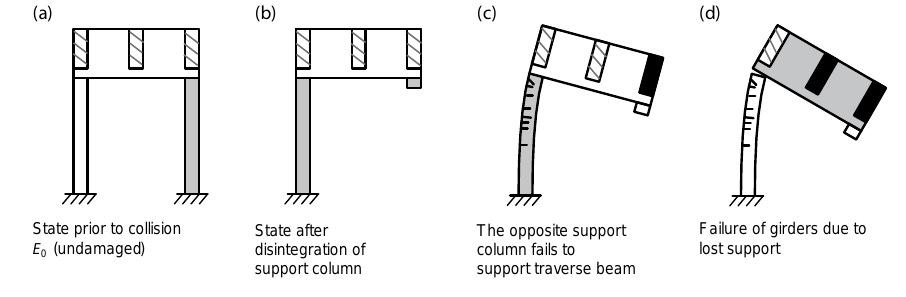
fig. 9. Simple visualisation of the event sequence of the road 26.5 bridge failure in Colorado